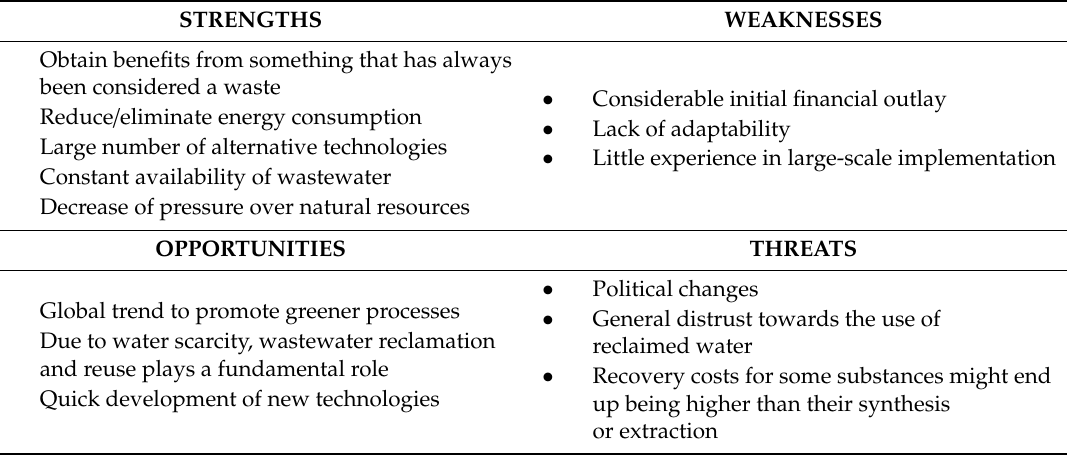
Table 13. SWOT analysis of the wastewater sector regarding the implementation of circular economy. STRENGTHS WEAKNESSES